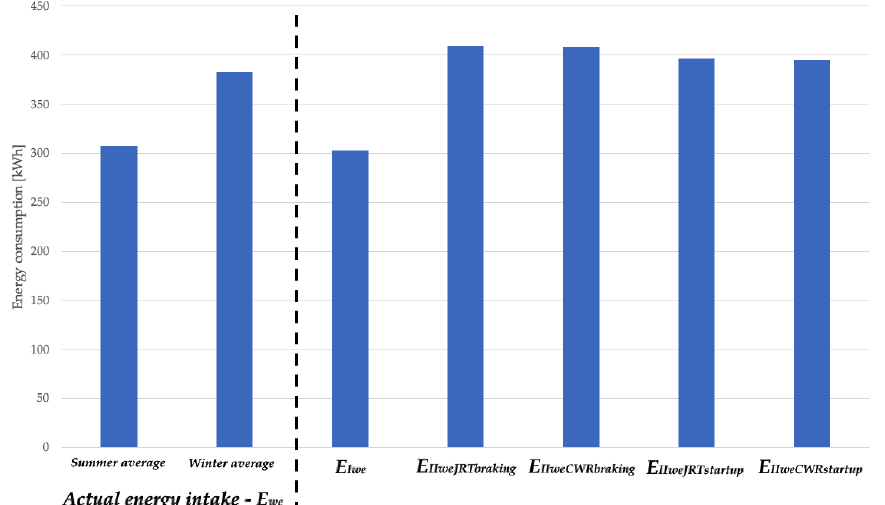
Figure 5. Comparison of electricity consumption for EN57AK´S: Lubliniec–Katowice route where vertical dashed line — exposure: real traction electricity consumption in correlation with the seasons (left side) in relation to Variant I and II (right side).